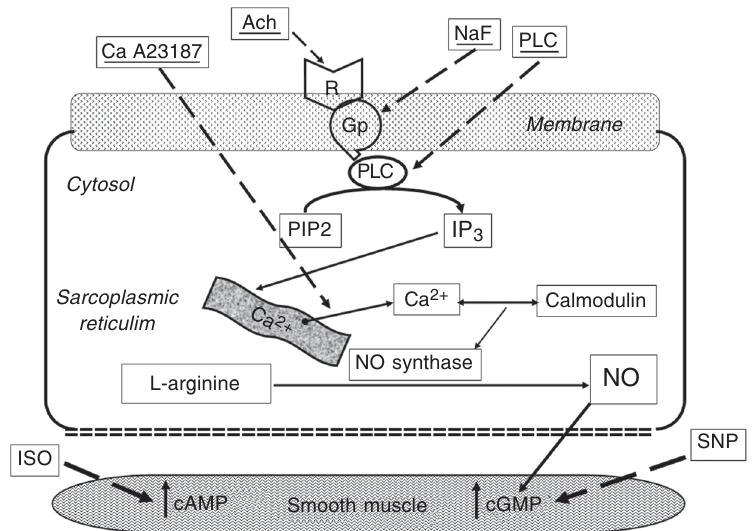
Figure 1. Schematic diagram of the nitric oxide (NO) release pathway and the pharmaco- logic agonists used in the in vitro organ chamber studies. Ca A23187 = calcium ionophor; Ach = acetylcholine; NaF = sodium fluoride; PLC = phospholipase C; R = receptor; Gp = G- protein; PIP2 = inositol diphosphate; IP 3 = inositol(1,4,5)-triphosphate; ISO = isoproterenol; SNP = sodium nitroprusside.